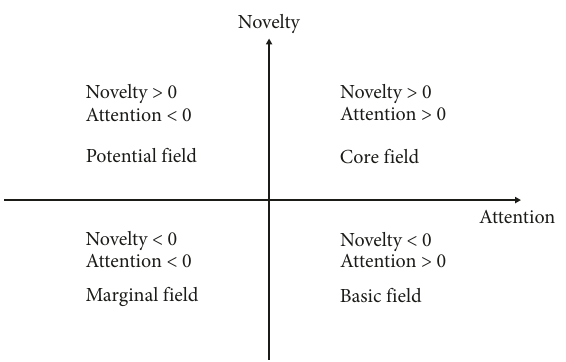
Figure 3: Strategic